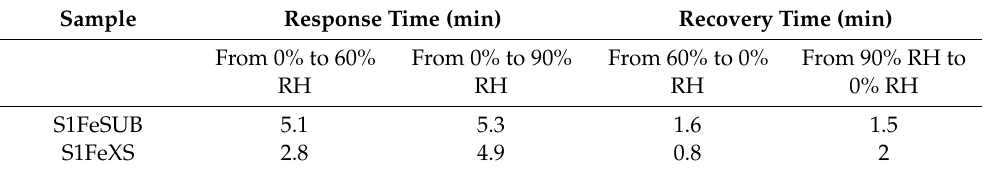
Table 5. Response time and recovery time for the S1FeSUB and S1FeXS sensors. Sample